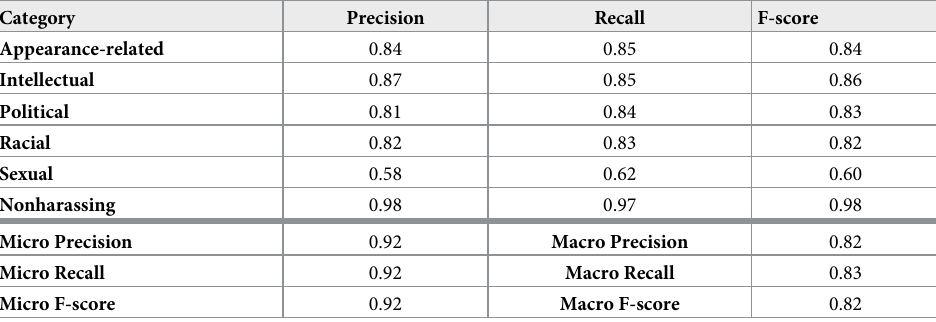
Table 8. Performance of our multi-class classifier for predicting type of harassment